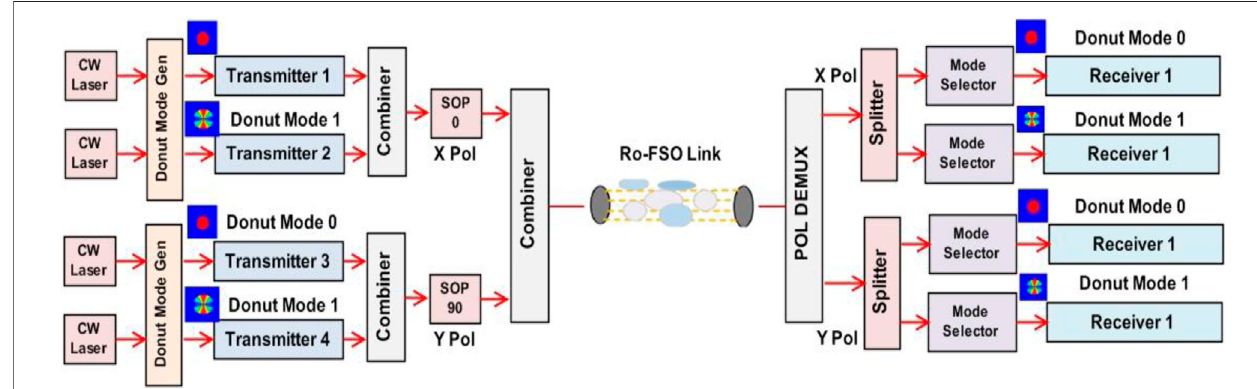
FIGURE 2 | MDM-PDM-Ro-FSO transmission system.